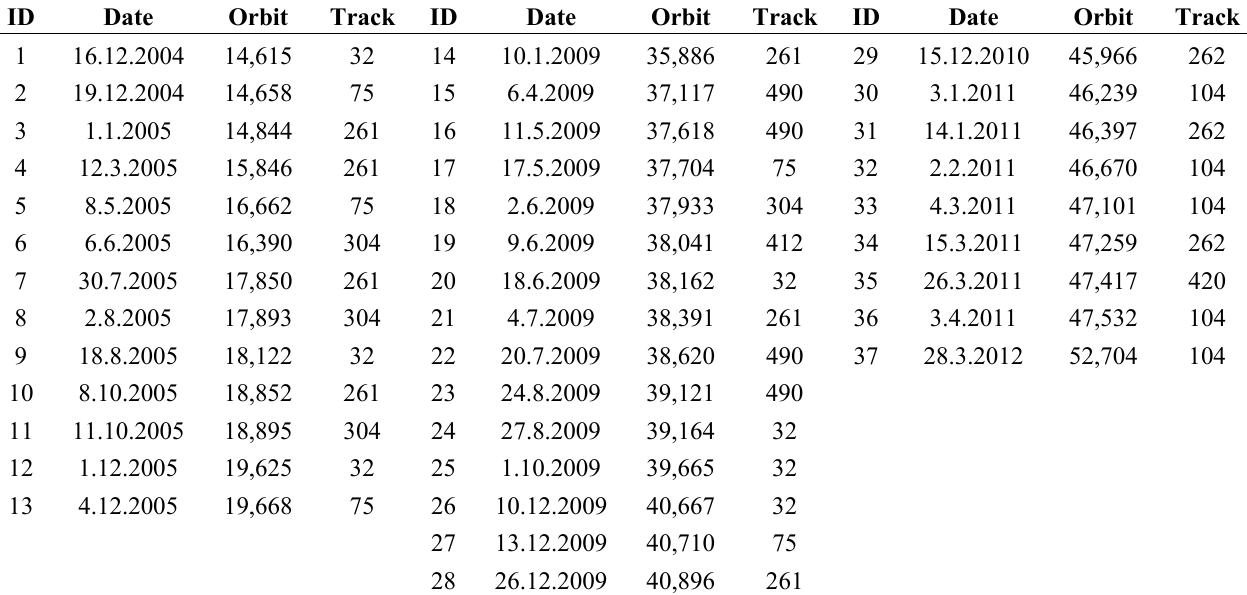
Table 1. The list of ENVISAT ASAR WSM images. Images are grouped into